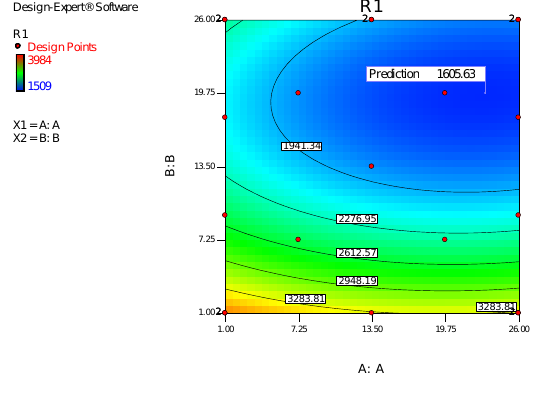
Figure 2 . Response surface of dataset.